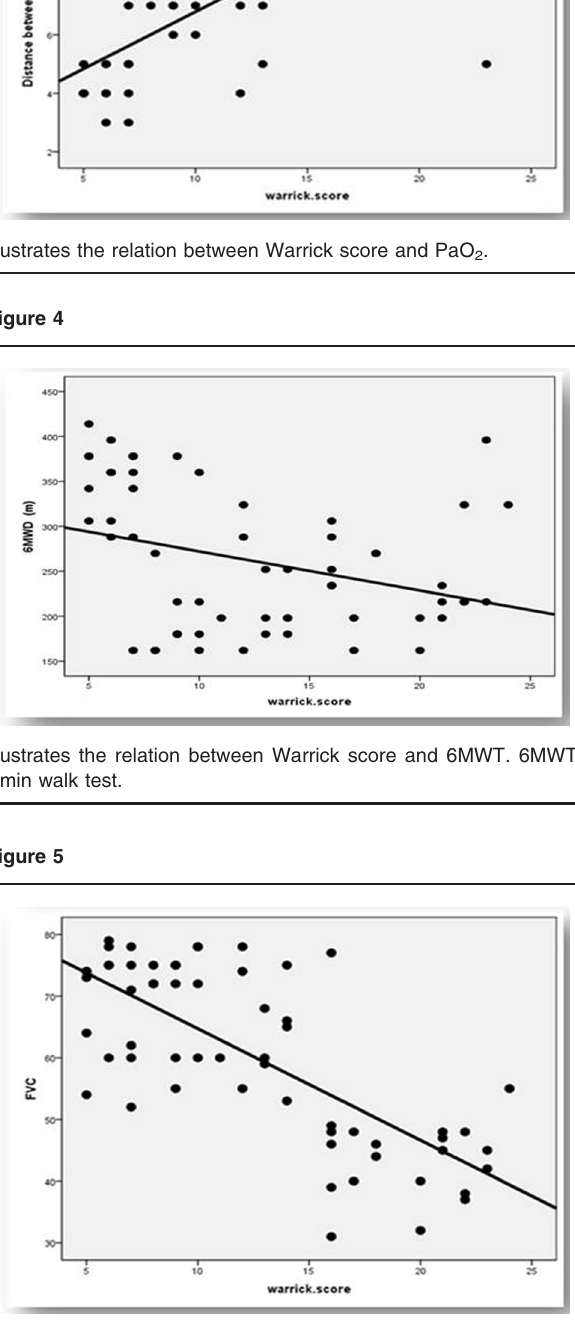
Illustrates the relation between Warrick score and FVC. FVC, forced vital capacity.